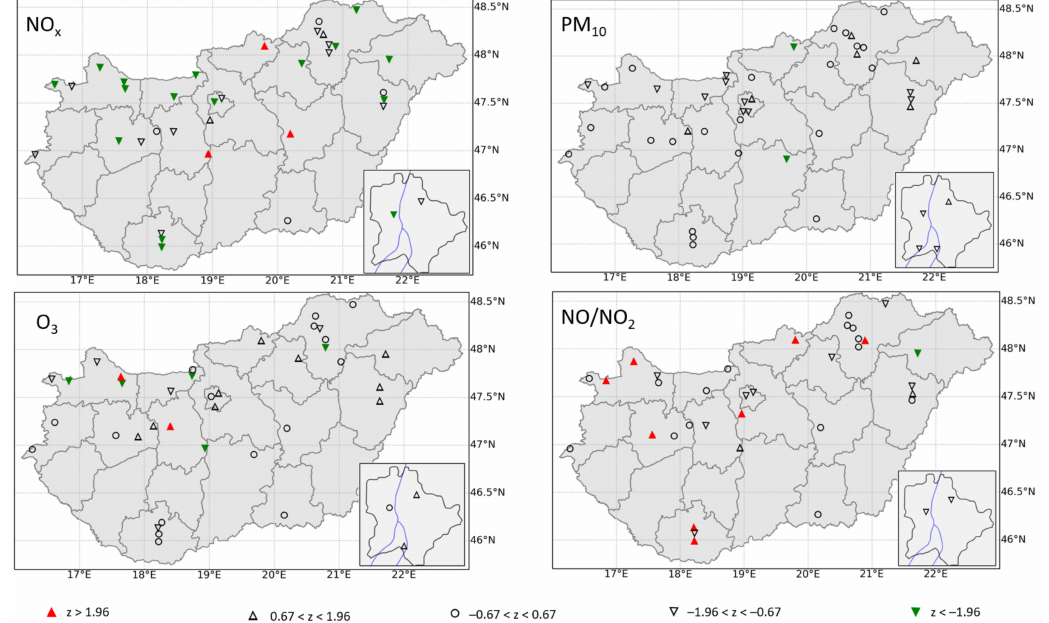
Figure 6. Difference of mean air pollutant concentrations and NO/NO 2 concentration ratio in the public emergency period (12 March–16 June) in 2020 relative to the same period in 2014–2019. Green/red triangles show a significant decrease/increase (concentrations of 2020 deviating from the mean of 2014–2019 with at least 1.96 SD). Black triangles show changes between 0.67–1.96 SD. Circles show changes of any direction less than 0.67 SD. Only monitoring sites with at least 4 years with >75% daily data availability in 2014–2019 and >75% daily data availability in 2020 are marked. (Note that some markers were shifted with max. 10 km to avoid